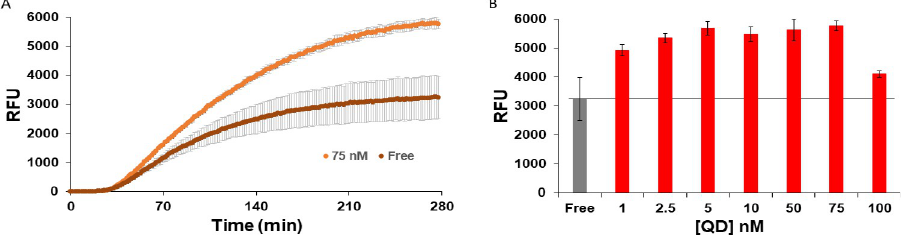
Fig 5. sfGFP production is enhanced with QDs in diluted PURExpress 1 reaction conditions. (A) Production of sfGFP over time with a range of QD concentrations present versus a negative control as monitored by fluorescence. Samples were excited at 485 nm and fluorescence monitored at 510 nm [69]. Plot for all the QD concentrations can be found in S6 Fig. (B) Yield of functional sfGFP, as estimated by average fluorescence from the end-range of the reactions, over the range of QD concentrations tested (red) as compared to the QD-free reaction (grey). When tested, all samples were statistically different from the free reaction, see S7 Fig and S1 Appendix.